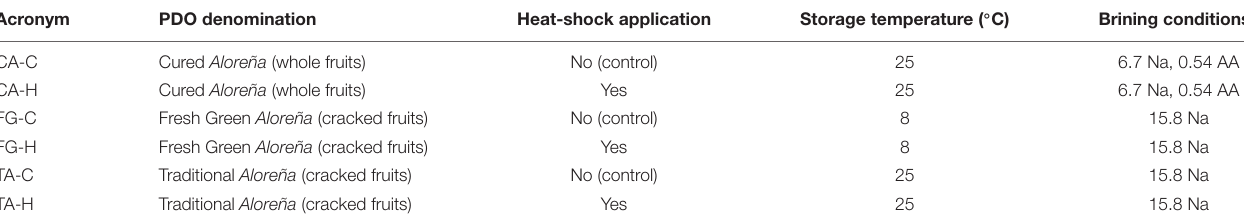
TABLE 1 | Summary of the experimental design applied in the